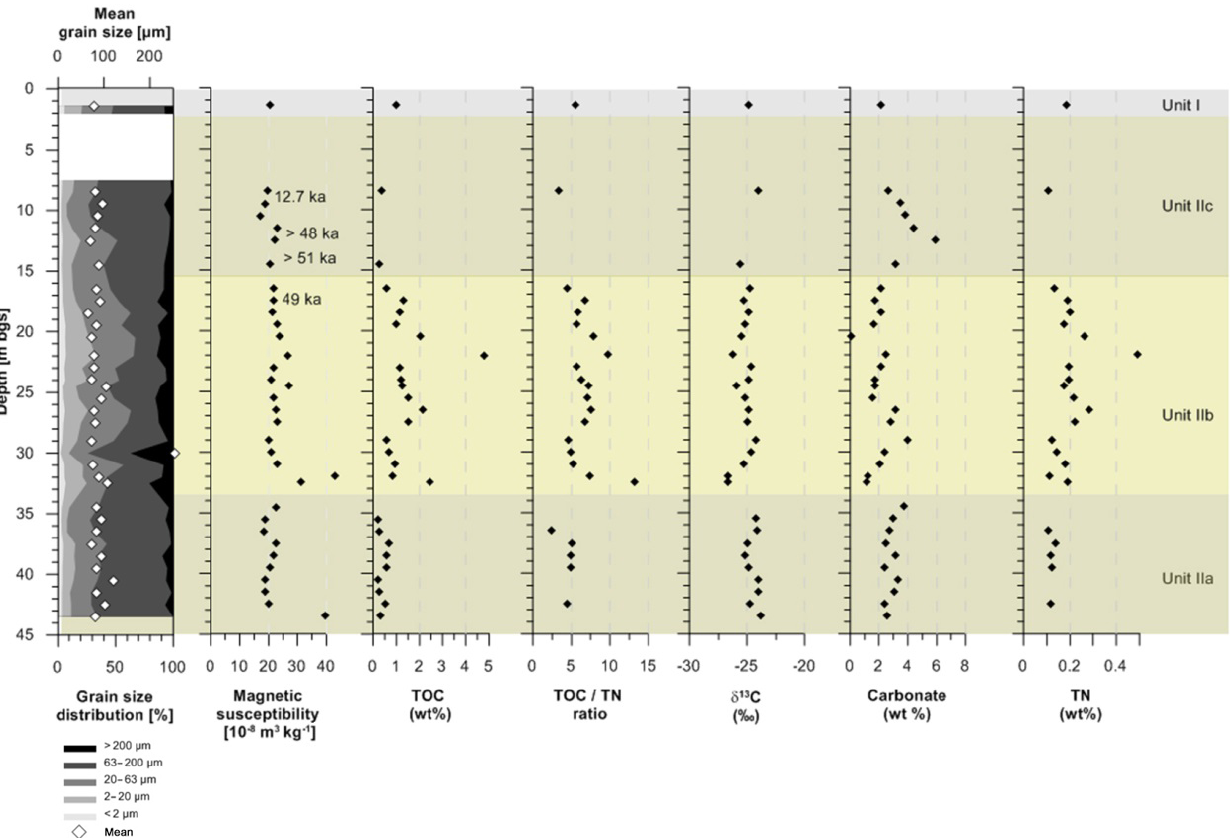
Figure 11. Diagram presenting grain size distribution, MS, radiocarbon ages, TOC, TOC / TN, δ 13 C, and carbonate records for section C.